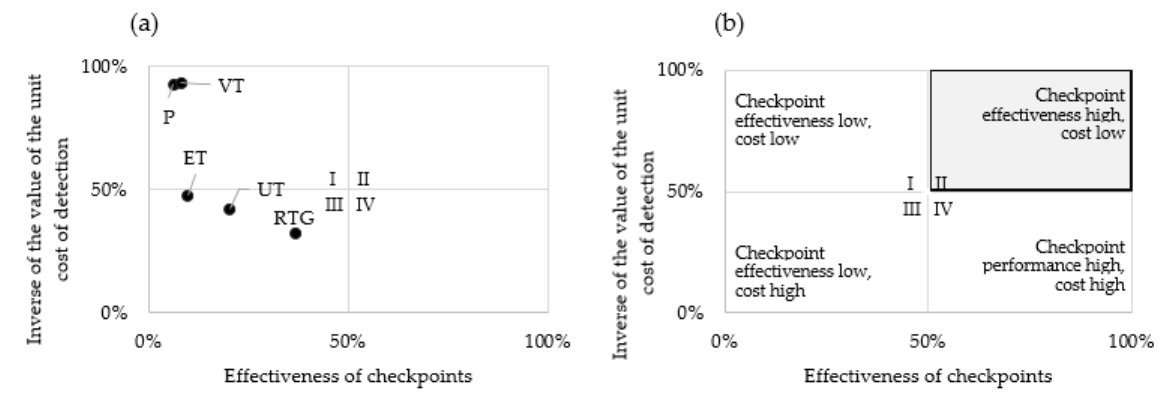
Figure 7. Matrix diagram showing ( a ) cost effectiveness of a given control point, ( b ) overview diagram.